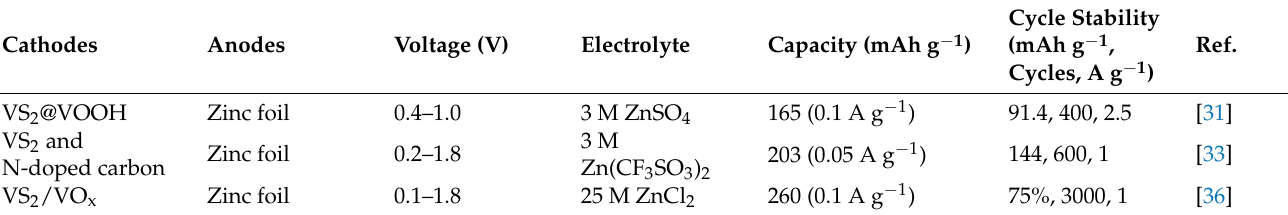
Figure 7. The electrochemical performance of Zn/Ni 3 S 2 batteries. ( a ) Schematic of nickel sulfide-adsorbing hydroxide radicals and being oxidized to form nickel hydroxide and sulfate radicals. ( b ) Gibbs free energies of Zn/Ni 3 S 2 batteries. ( c ) The cycling stability of the flexible ZC12NS battery. Reproduced with permission [70]. Copyright 2021, Elsevier B.V. and Science Press. ( d ) Rate capability. ( e ) The long-term performance. Reproduced with permission [71]. Copyright 2021, Elsevier B.V. Table 1. The electrochemical performance of TMC cathodes.